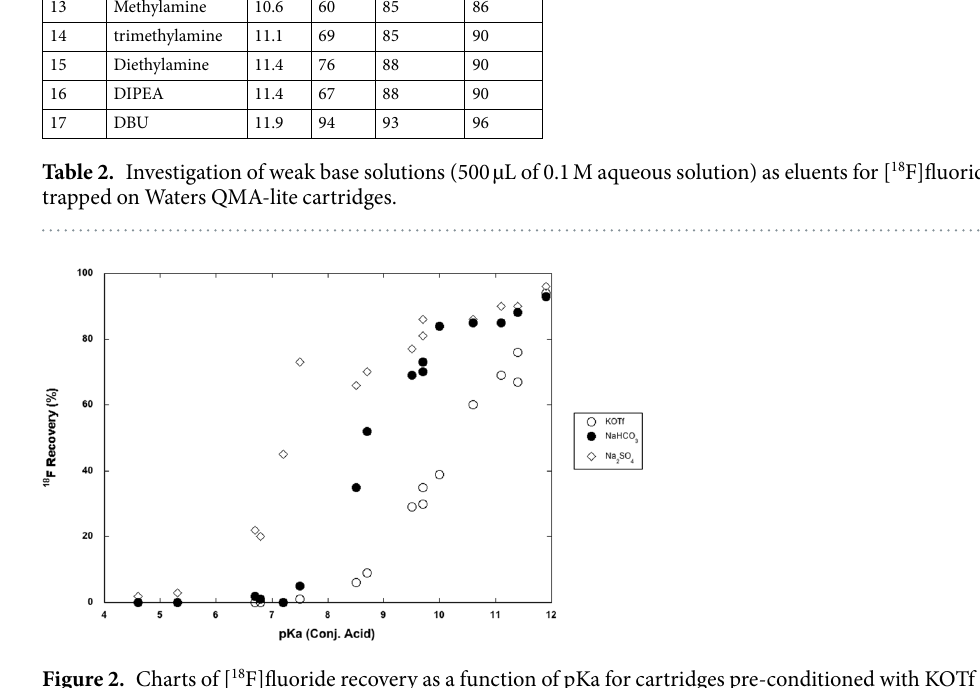
Figure 2. Charts of [ 18 F]fluoride recovery as a function of pKa for cartridges pre-conditioned with KOTf ( ○ ), NaHCO 3 ( ● ) or Na 2 SO 4 ( ◊